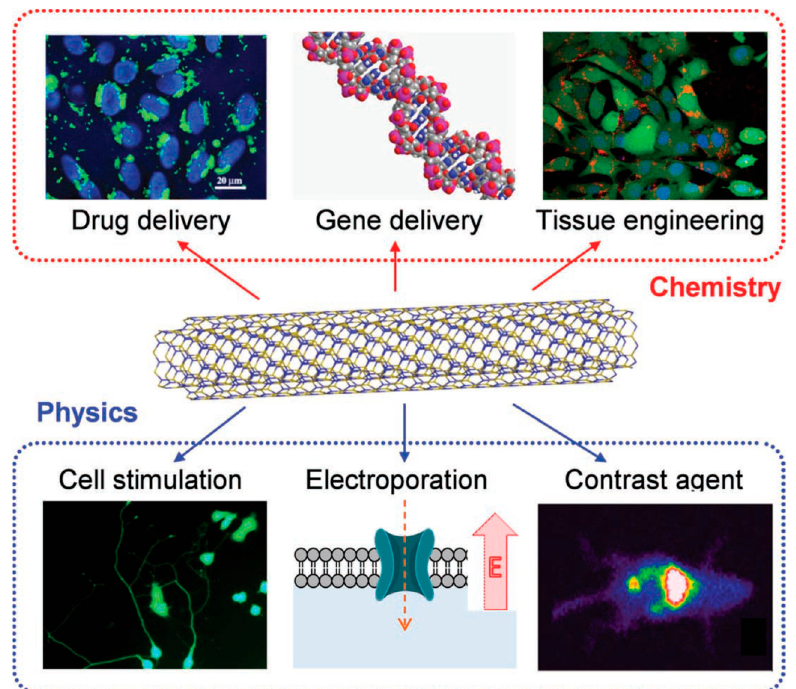
Figure 5. Schematic representation of potential applications of BNNTs in biomedicine. Adapted with permission from [81]. Copyright 2013 Wiley-VCH Verlag GmbH & Co. KGaA, Weinheim.